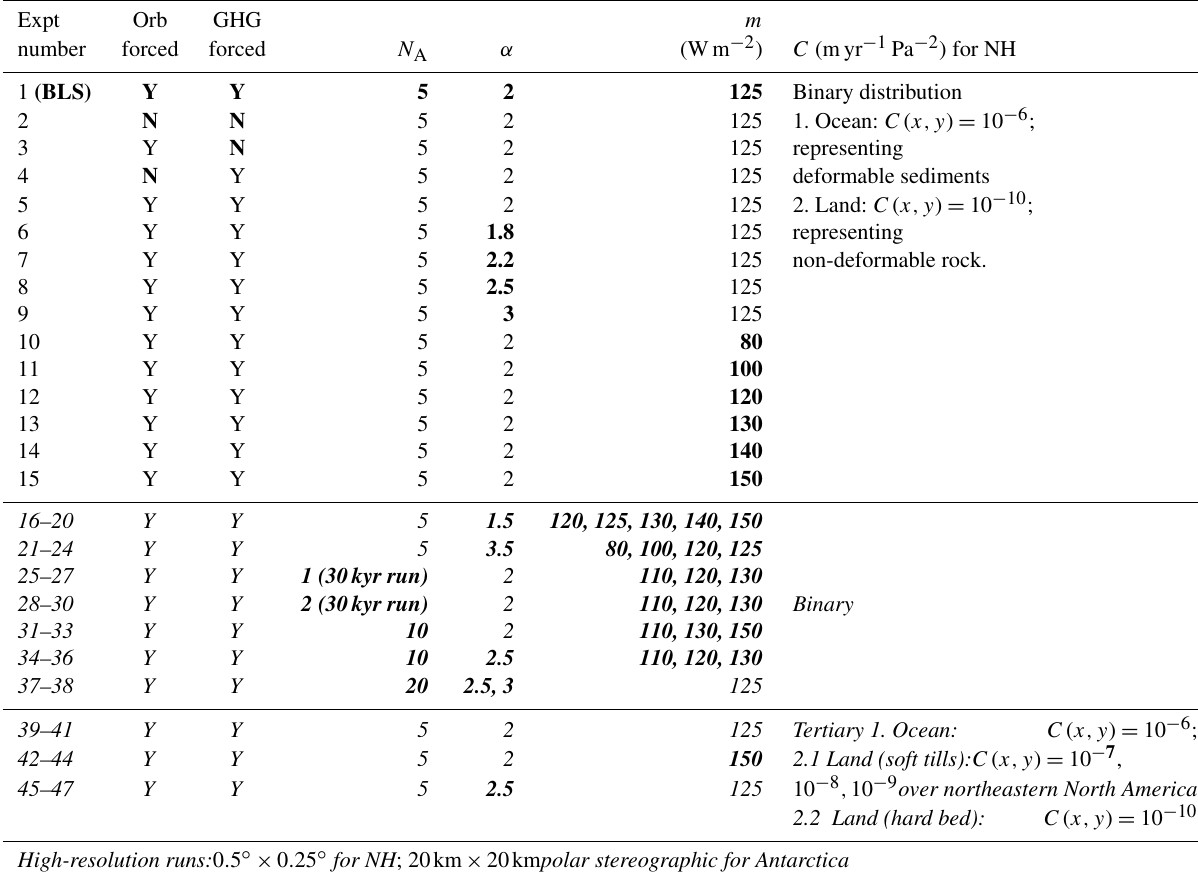
Table 1. List of all ensemble runs performed for the study (shown in Fig. S3). The first 15 experiments are discussed in Sect. 3.1 and shown in Fig. 3. Values in bold represent the difference from the baseline simulation (BLS; experiment number 1 )and experiments in italics are not presented in Fig. 3. N A represents the PSUIM vs. LOVECLIM acceleration factor (Sect. 2.3). α represents the GHG sensitivity scaling factor (Eq. 1, Sect. 2.1), and m represents the constant parameter in the surface energy balance equation (Eq. 3, Sect. 2.2). C represents the basal sliding coefficient map used for the NH (Eq. 7, Sect.